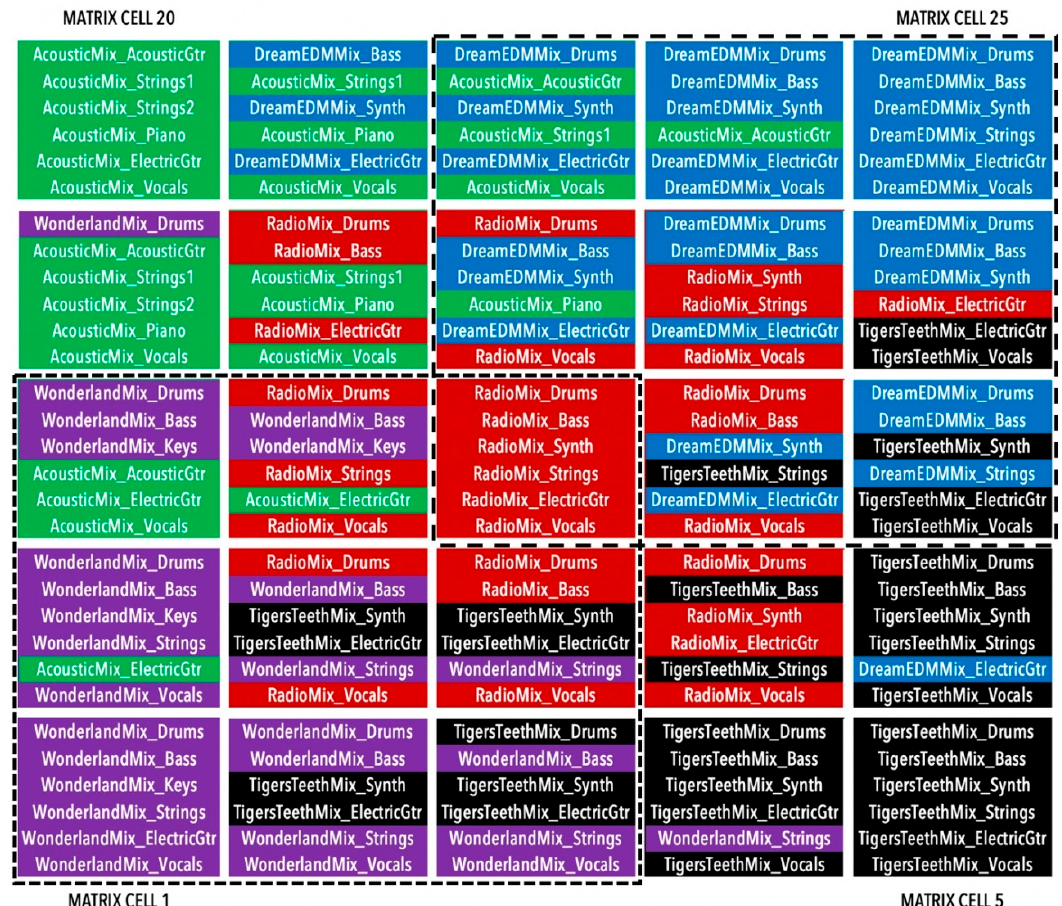
Figure 7. The stem layout for Circus , with song versions indicated via color coding. Two example families are indicated by hatched boxes, the red-colored radio mix being in both.